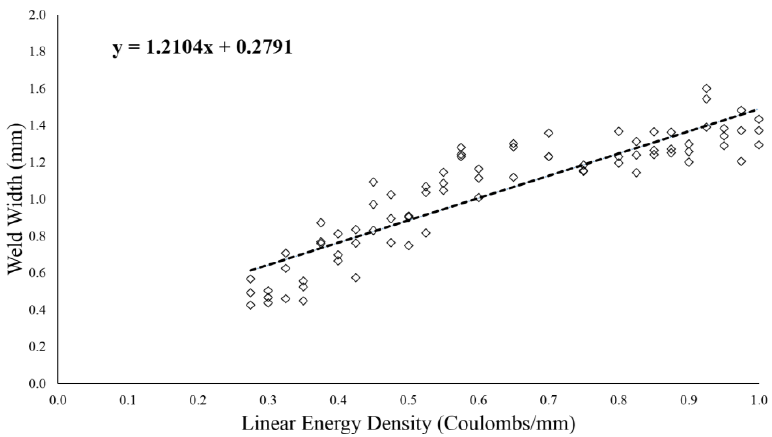
Figure 8. Weld width as a function of linear energy density for 20 mm/s on three layers of LLDPE.